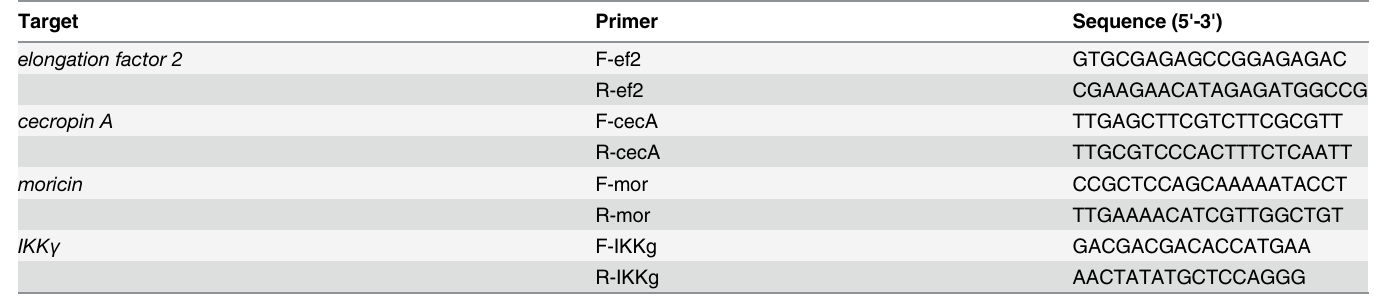
Table 1. Primers used in this